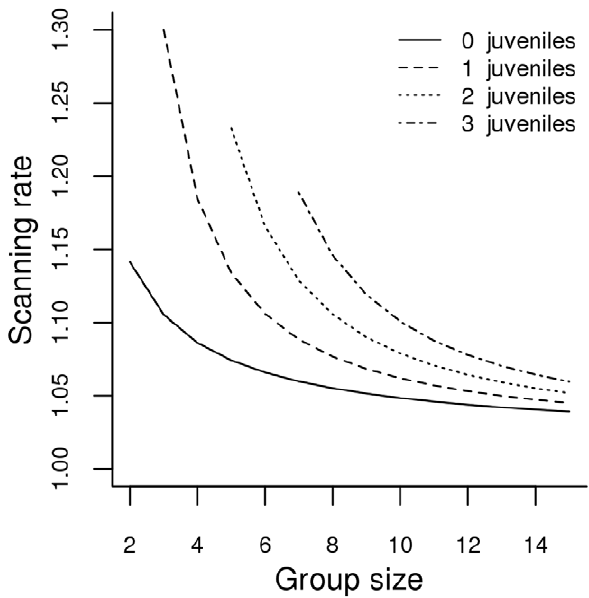
Figure 2. Changes in scanning rates (vigilant acts per minute) as a function of group size and number of juveniles for barren females according to model 4 (Security model with mothers accompanied by